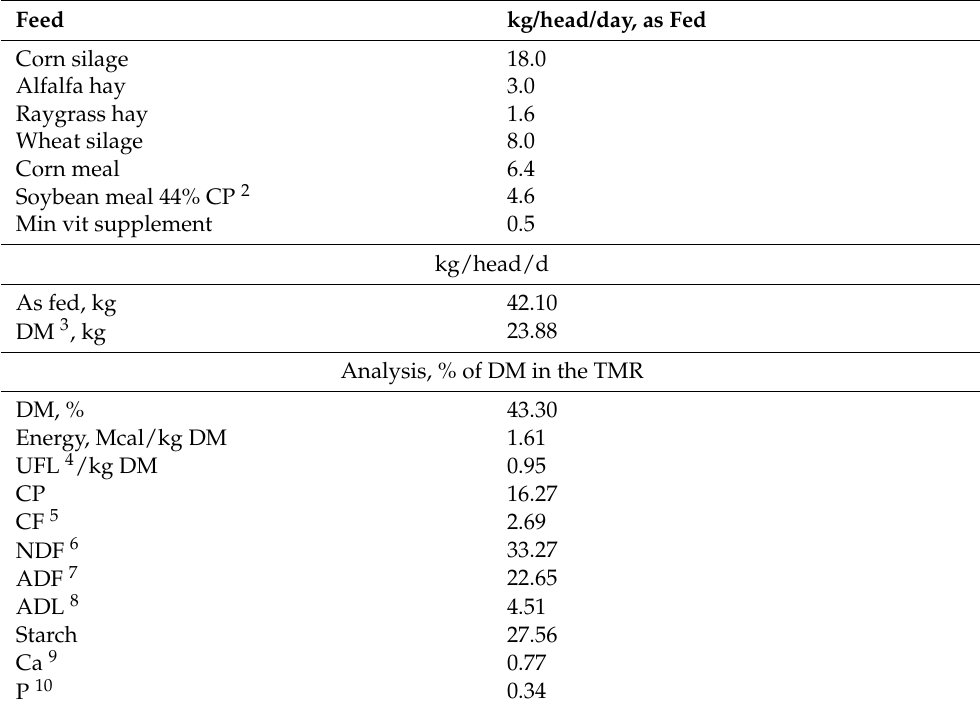
Table 3. Nutritional composition and values of the total mixed ration (TMR) used for in vivo study (predicted by Plurimix 1 , a ration balancing software